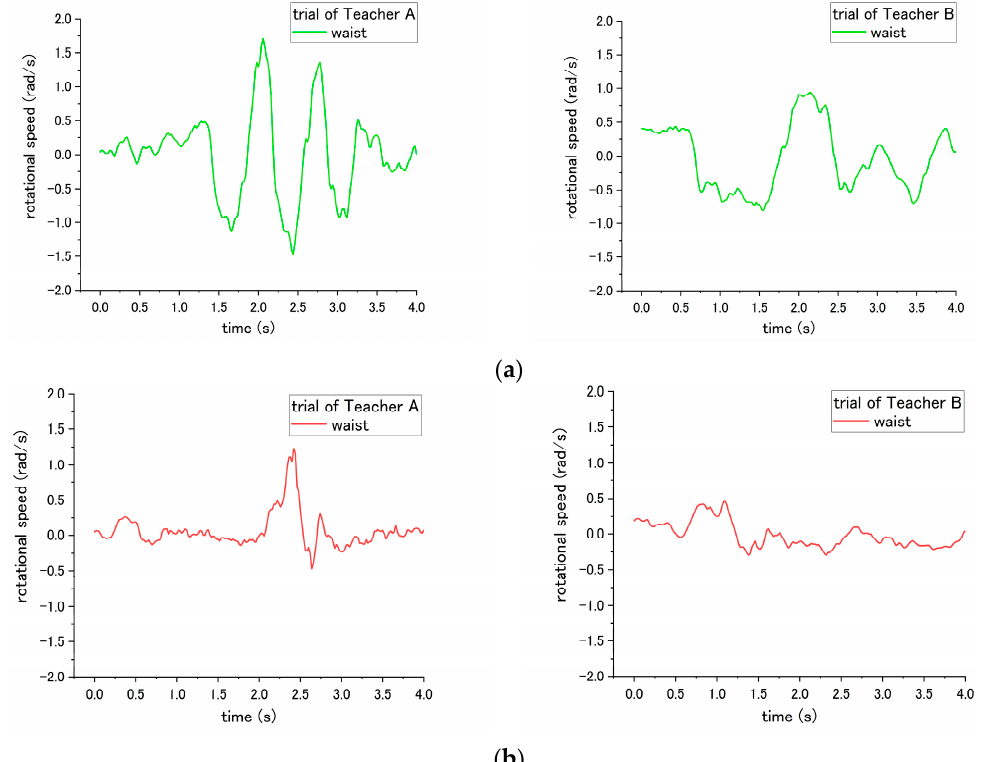
Figure 11. Rotational speed of patient’s waist during step No. 5 when the ( a ) correct way, and ( b ) incorrect way 5-(1) were conducted at step No. 5. Table 3. Results of rotational speed.